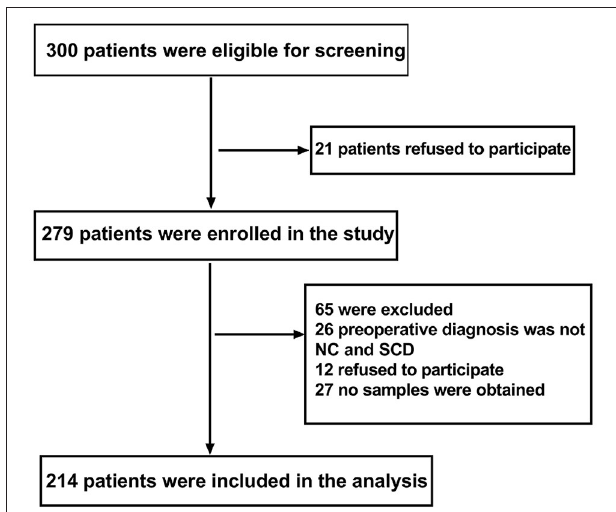
FIGURE 1 | Flow diagram. The flow diagram shows that 300 patients were initially screened for the studies, and 214 patients were finally included in the data